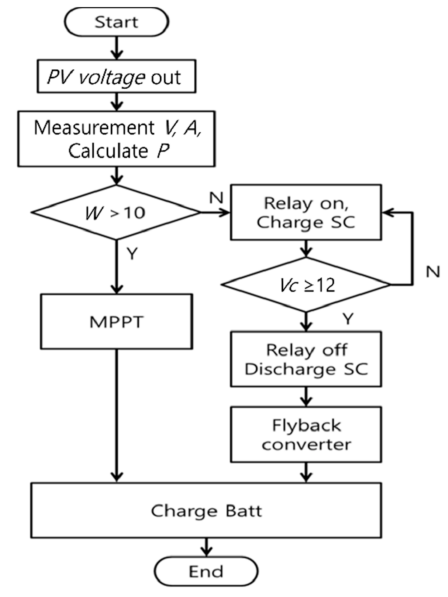
Figure 4. System